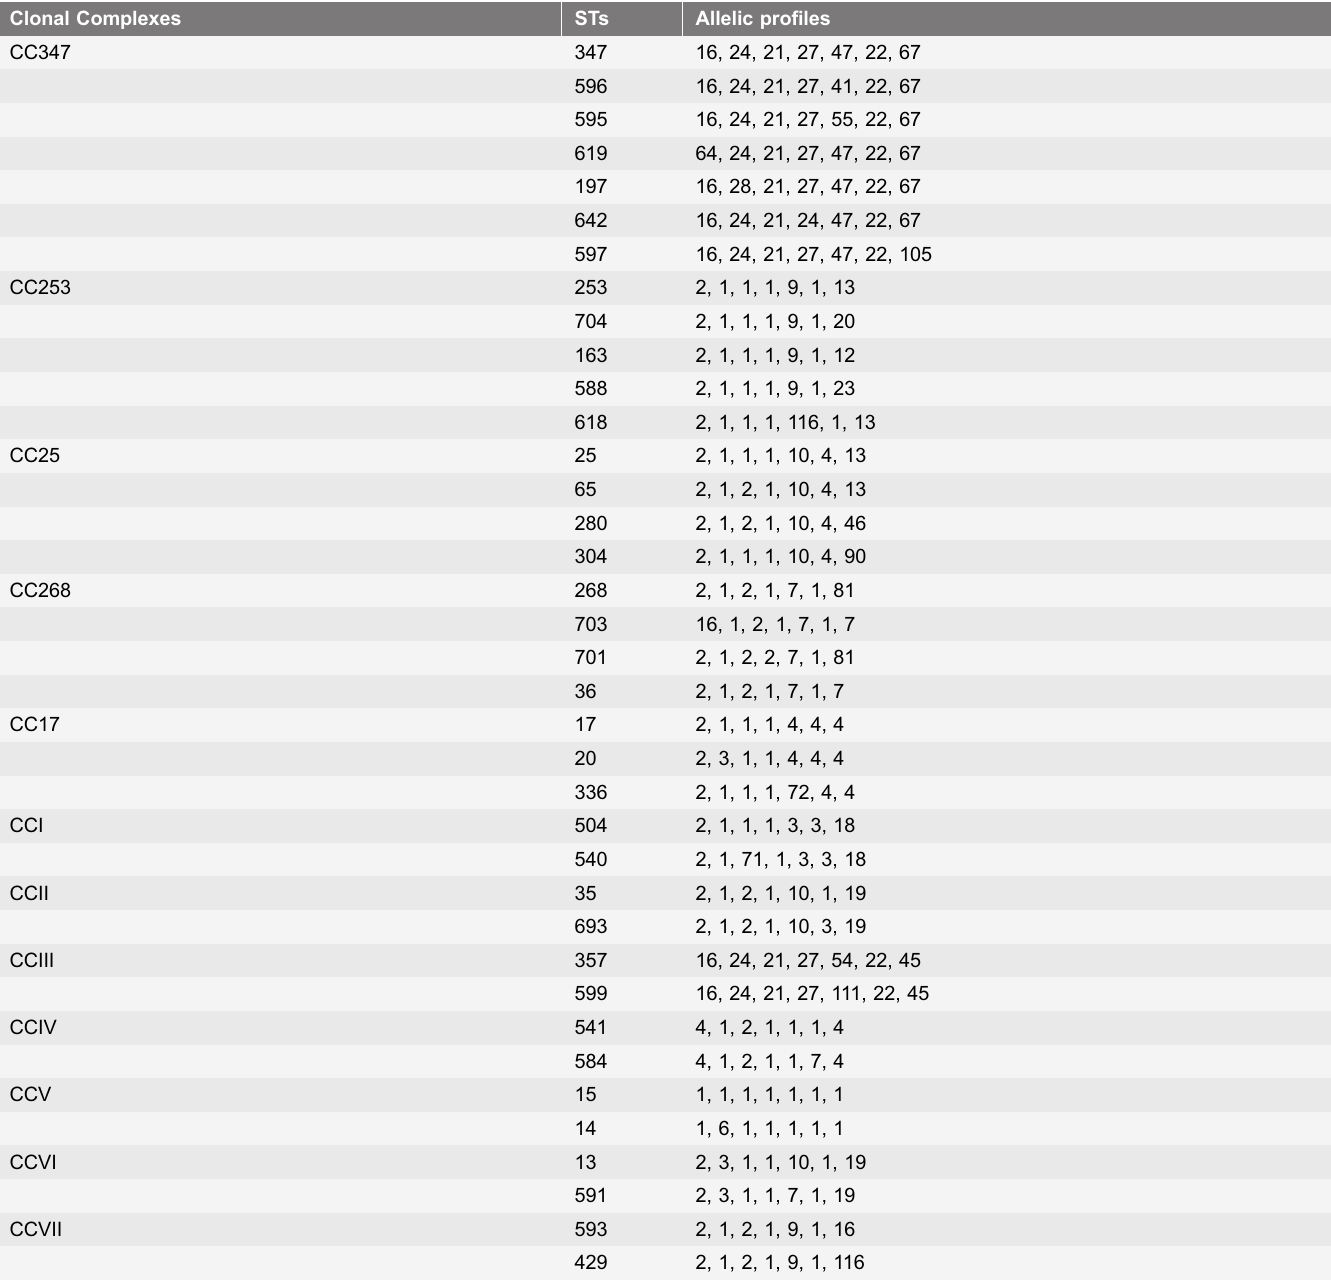
Table 2. eBURST analysis of the MLST data: illustration of clonal complexes based on STs and their allelic profiles. Clonal Complexes